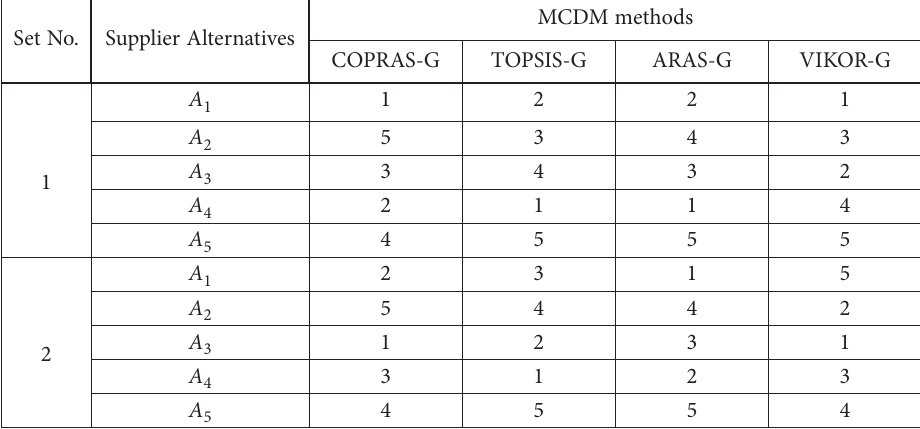
Table 14. The ranking results with different methods in different sets Set